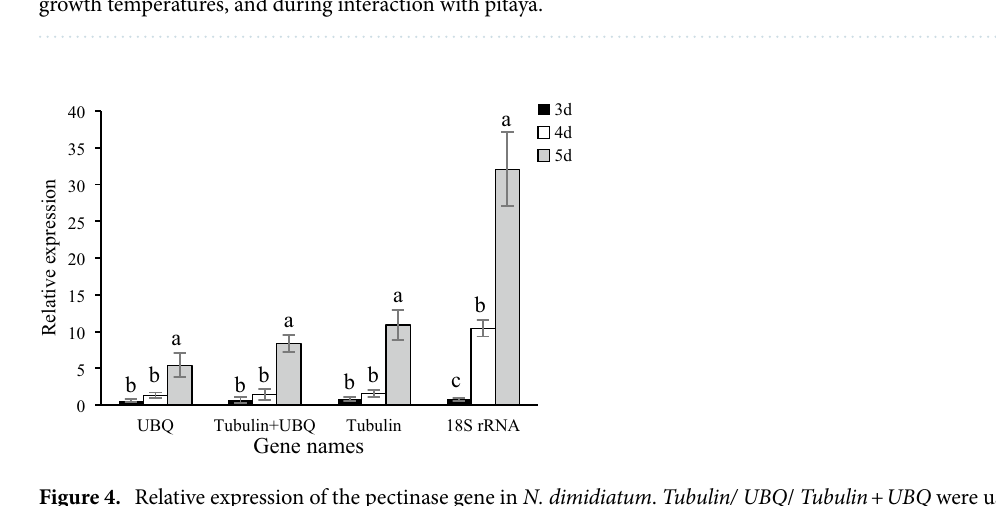
Figure 3. Pairwise variation (V) analyses of the seven candidate reference genes using the geNorm algorithm. “All conditions” corresponds to the comparison of N. dimidiatum at different developmental stages, at different growth temperatures, and during interaction with pitaya.